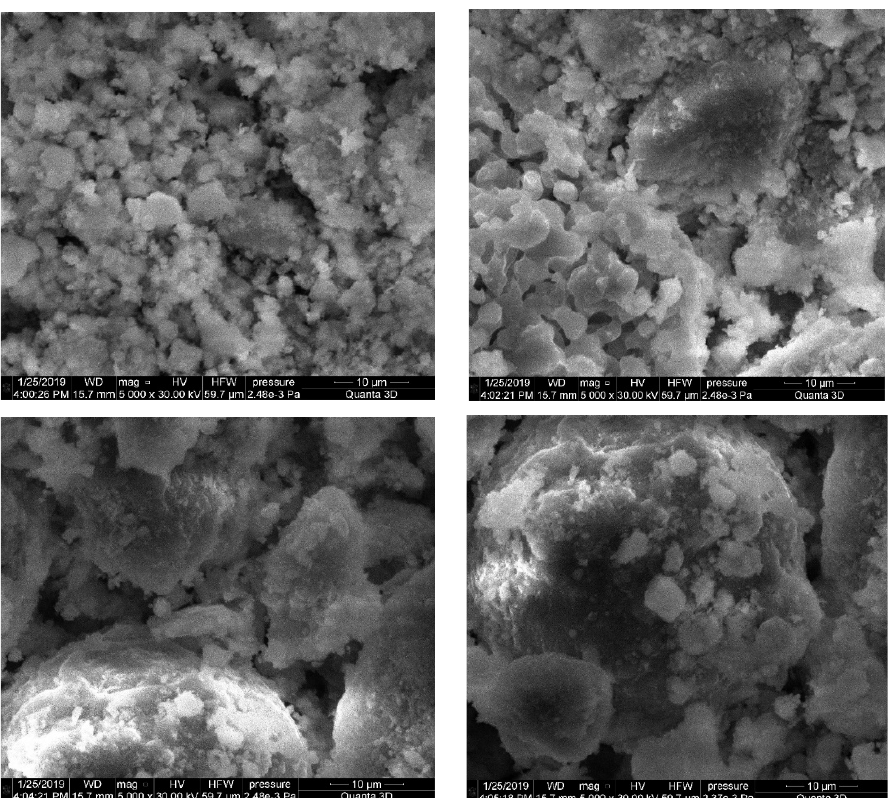
Figure 5. SEM images of the aspiration dust.